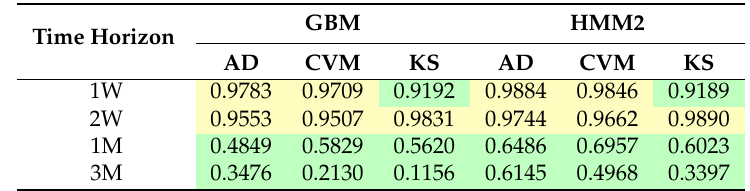
Table 1. Backtesting results for USD/EUR with calibration window T c = 3 years, frequency of re-calibration δ c = 3 months, and backtesting window T b = 10 years. GBM, Geometric Brownian Motion.